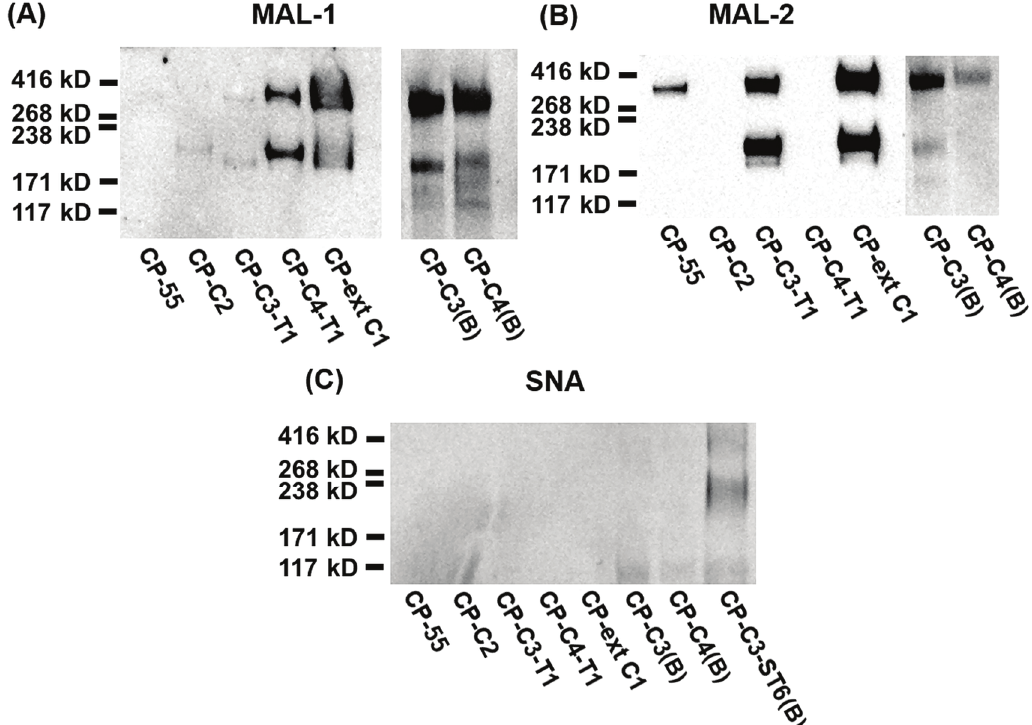
Figure 4. SDS-PAGE and Western blot analysis of purified PSGL-1/mIgG2b carrying (cid:2)2,3-sialylated O -glycan core structures. For Western blot analyses, 0.2 μ g of recombinant protein were loaded and analyzed on SDS-PAGE under non-reducing conditions. After blotting, membranes were probed with Maackia amurensis lectin-1 (MAL-1) ( A ), Maackia amurensis lectin-2 (MAL-2) ( B ), and Sambucus nigra agglutinin (SNA) ( C ). MAL-1 recognizes the type 2 chain (Gal β 4GlcNAc) with or without (cid:2)2,3-linked sialic acid; MAL-2 detects terminal (cid:2)2,3-linked sialic acids; SNA detects terminal (cid:2)2,6-linked sialic